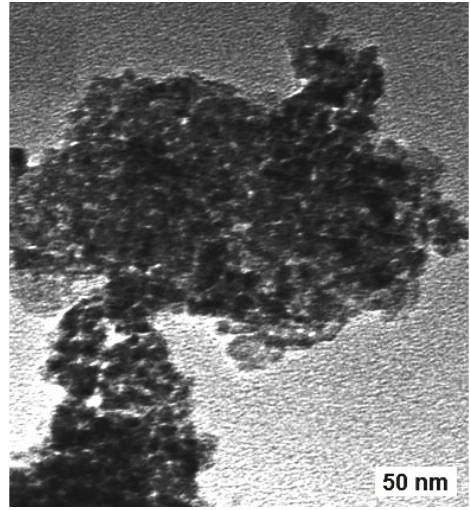
Fig.5. TEM image of cerium oxide nanoparticles